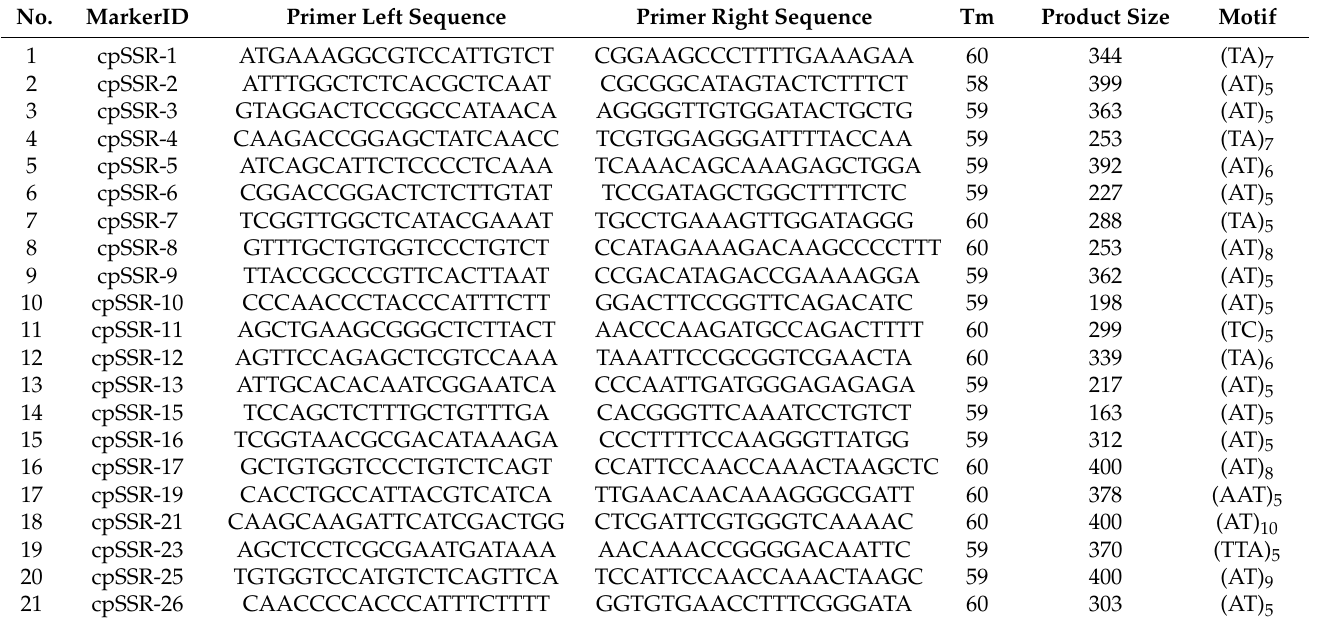
Table 1. Characteristics of twenty-one cpSSR markers for tree